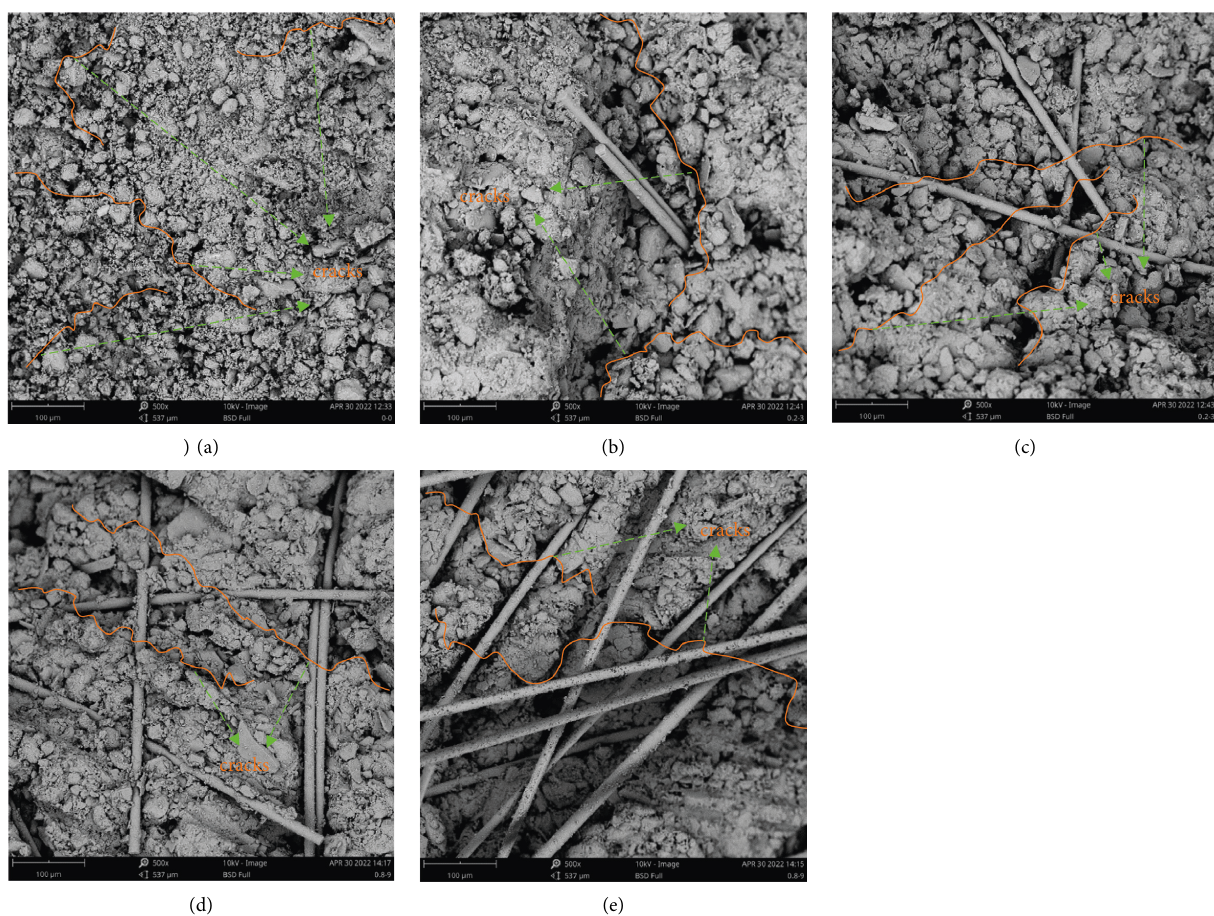
Figure 10: Comparison of different ratios of glass fiber (500 times magnification) (a) 0% plain soli (b) 0.2% incorporation soli (c) 0.4% incorporation ratio (d) 0.6% incorporation ratio (e) 0.8% incorporation